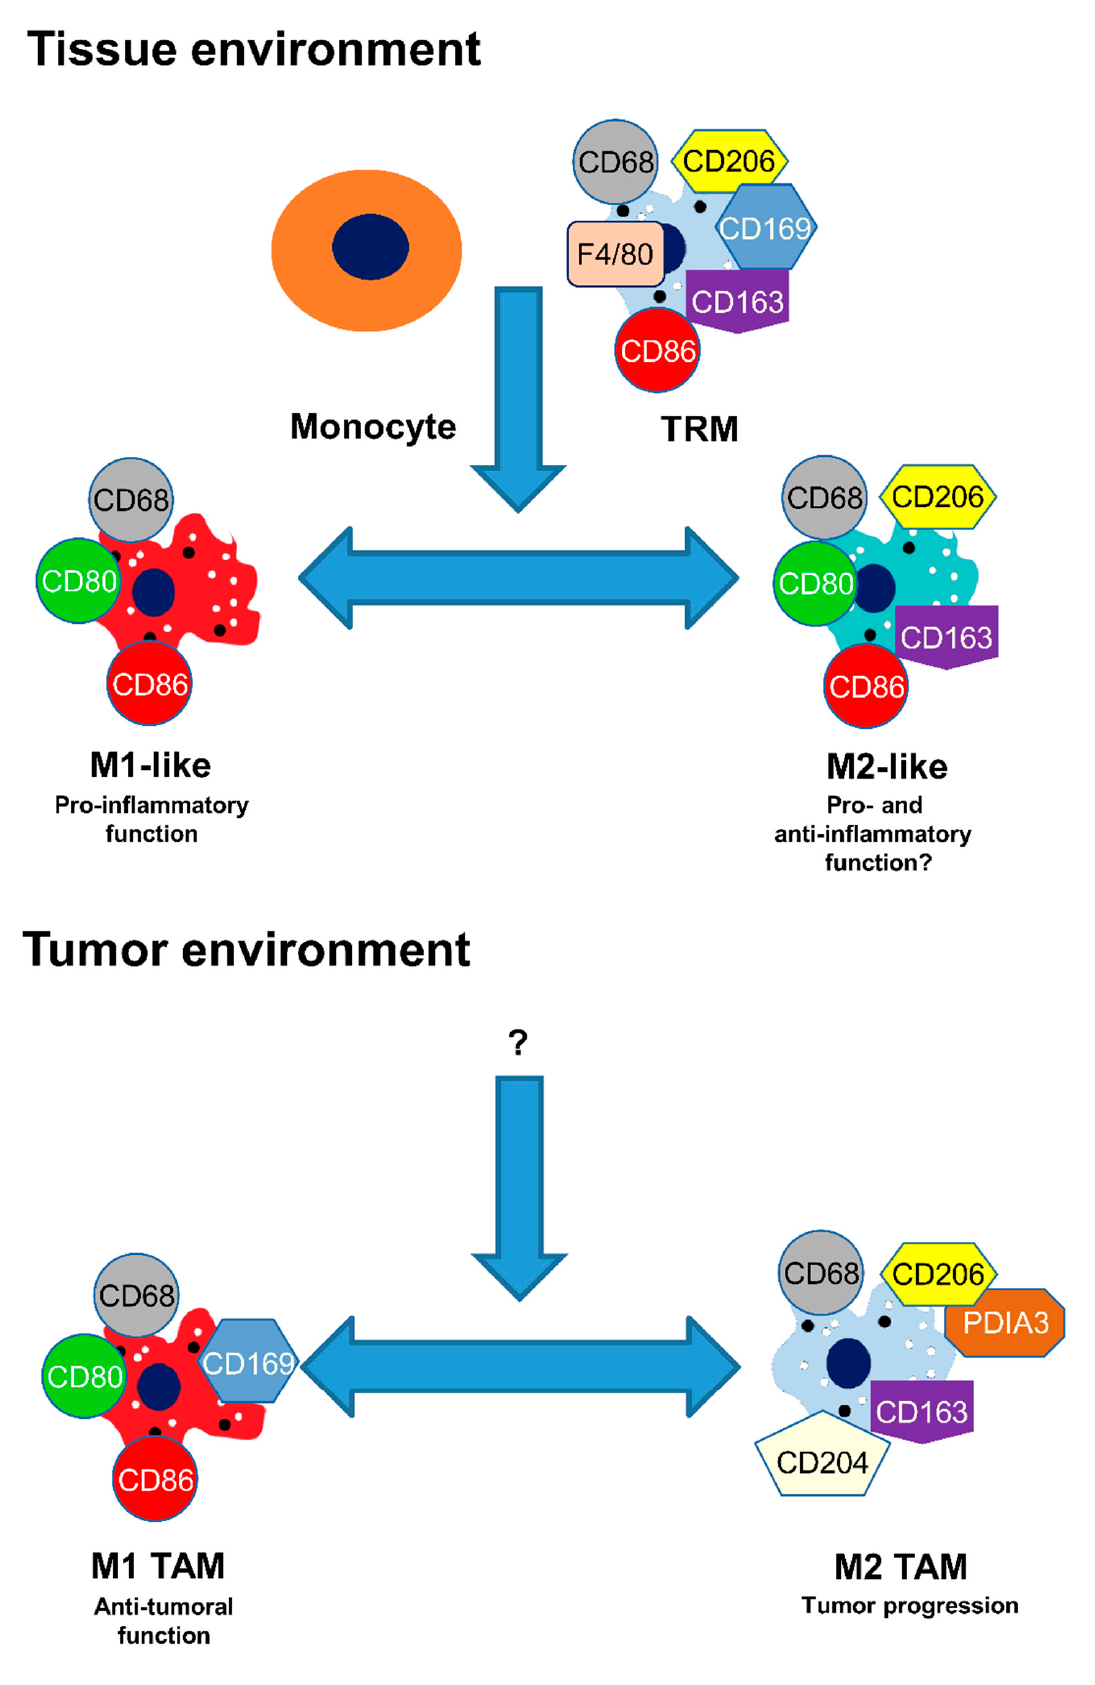
Figure 2. In vivo macrophage plasticity. Tissue Resident Macrophage (TRM), Tumor Associated Macrophage